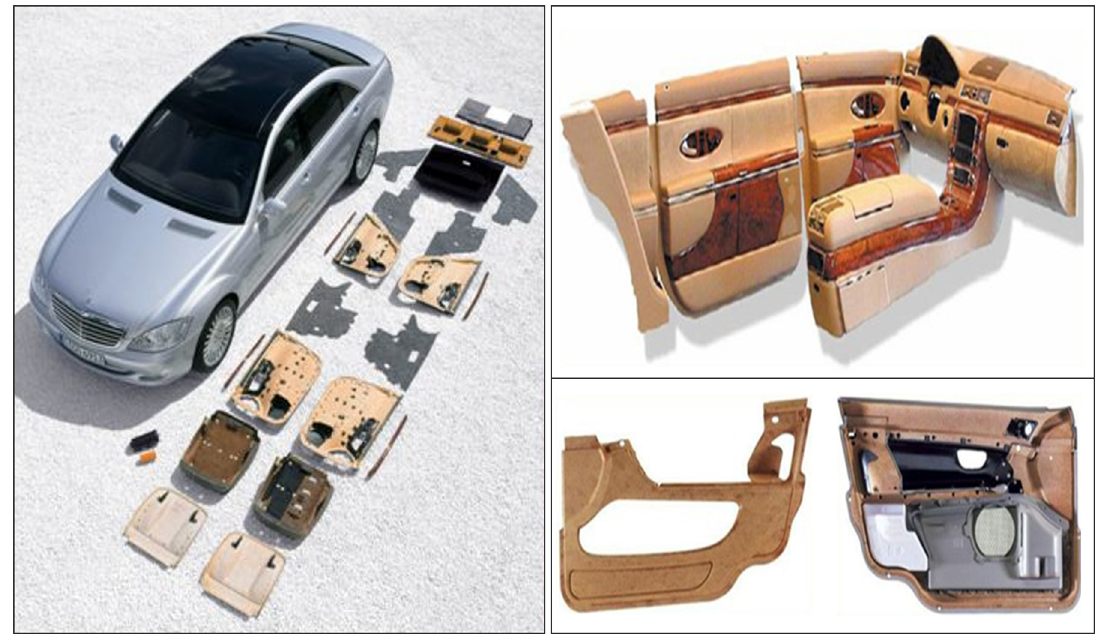
Figure 1. Automobile components based on polymer composites reinforced with lignocellulosic fibers.